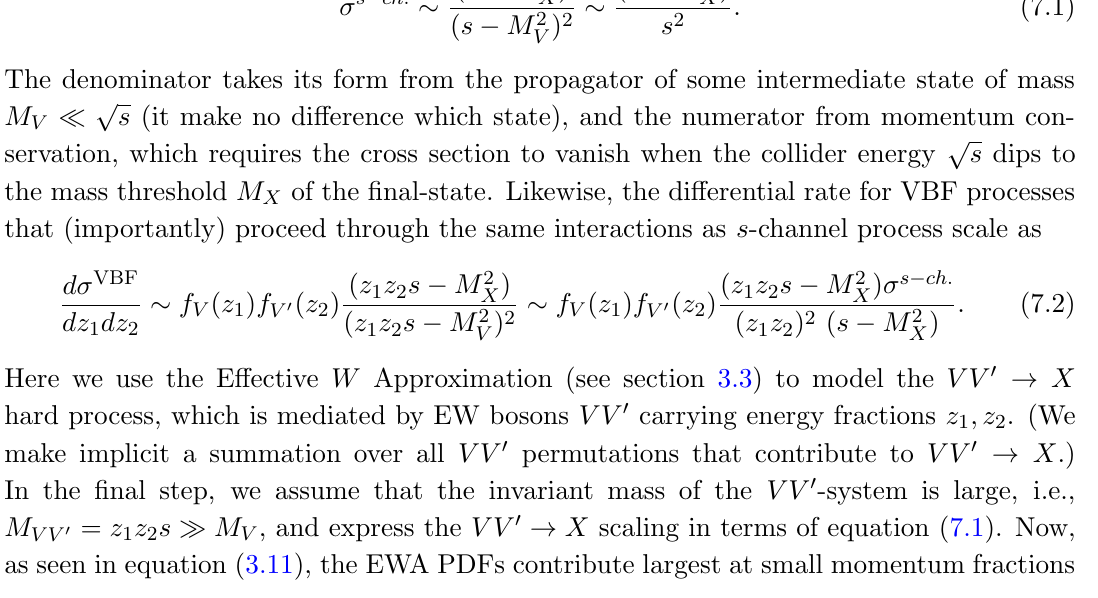
Table 9 . For representative processes and inputs, the required muon collider energy at which the VBF production cross section surpasses the s -channel, annihilation cross section, as shown in (cid:12)gure 17. Also shown are the cross over energies as estimated from the scaling relationship in equation (7.7) assuming a mass scale M X (2 M X